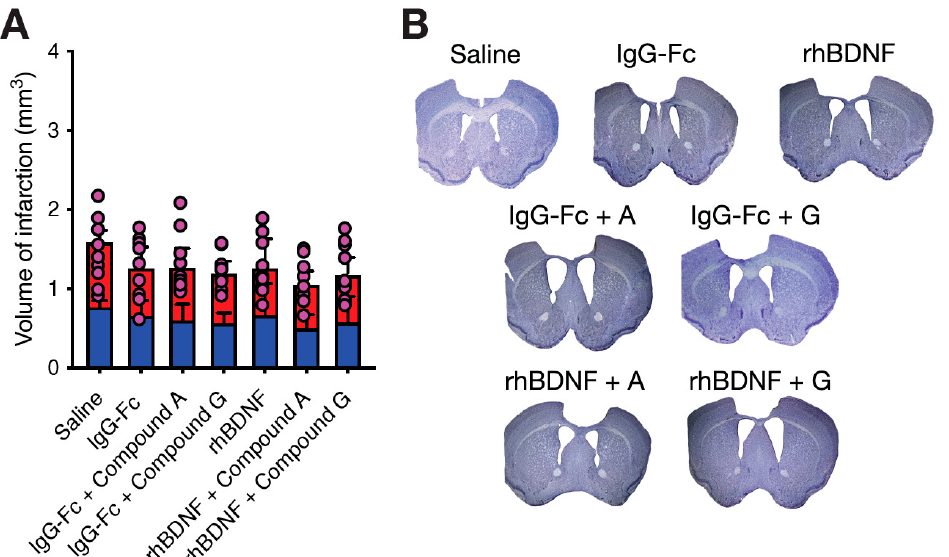
Figure 1. Quantification of infarct volumes at day-35 post-stroke. Assessment of infarct volumes found no significant differences in total infarct volumes (pink dots, ( A )), regardless of saline ( n = 10), IgG-Fc ( n = 10), IgG-Fc + compound A ( n = 10), IgG-Fc + compound G ( n = 10), rhBDNF ( n = 9), compound A + rhBDNF ( n = 9) or compound G + rhBDNF treatment ( n = 9). Similarly, no asymmetrical differences were observed in hemispheric damage across all stroke animals (left hemisphere, blue bar; right hemisphere, red bar; ( A )). Representative PFC strokes are shown for all treatment groups in ( B ), including a section from a saline-treated sham animals for comparison.